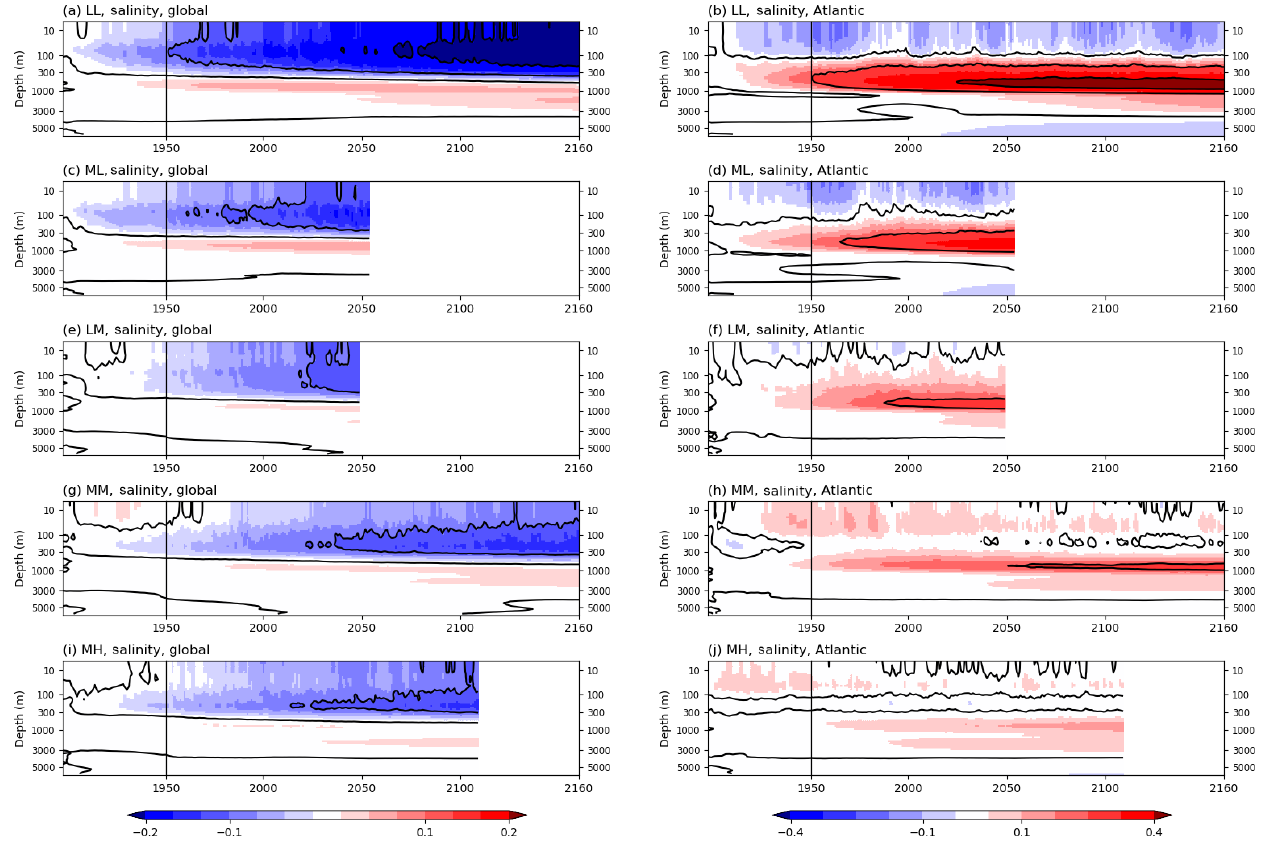
Figure 11. As Fig. 10 but for ocean salinity, again with different scales on the left and